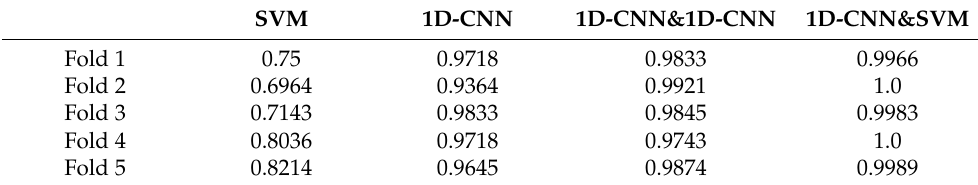
Table 3. The 5-fold cross-validation results of the 4 methods on the test set. SVM 1D-CNN